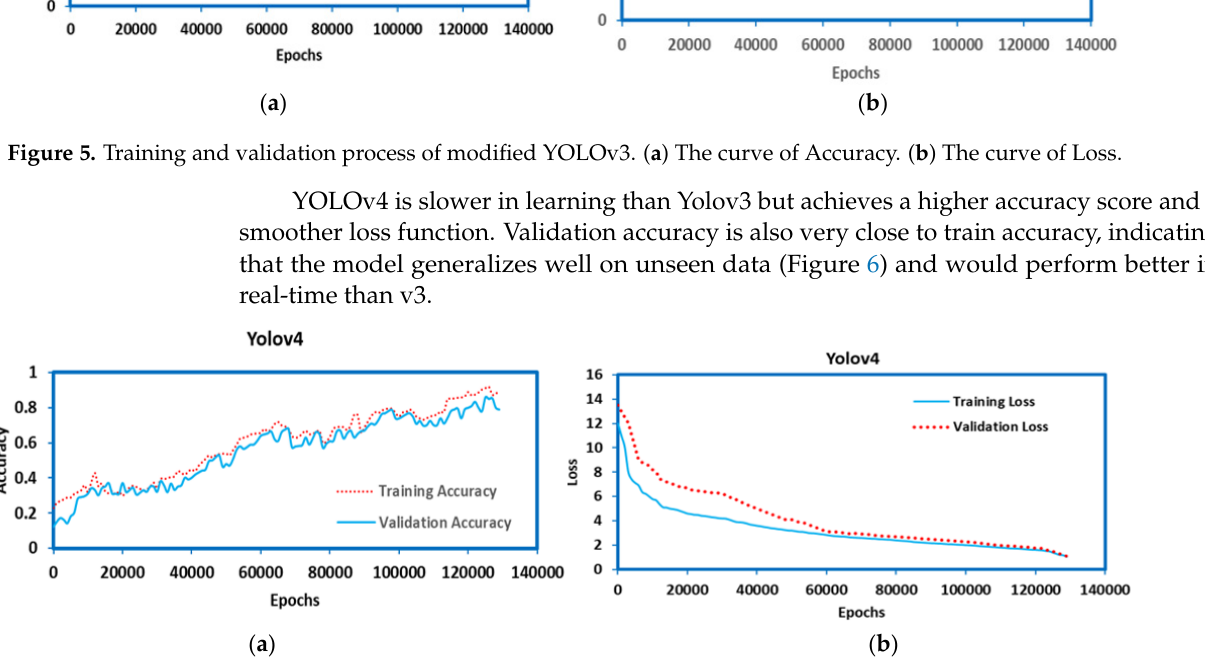
Figure 6. Training and validation process of modified YOLOv4. ( a ) The curve of Accuracy. ( b ) The curve of Loss.